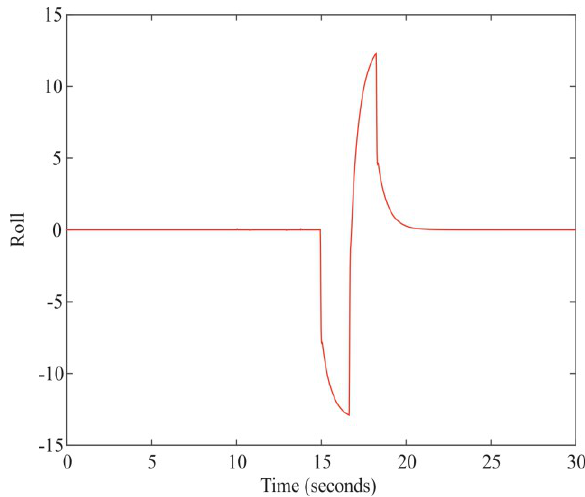
Fig. 13. The response of the object using a cascade controller (direction of Roll)